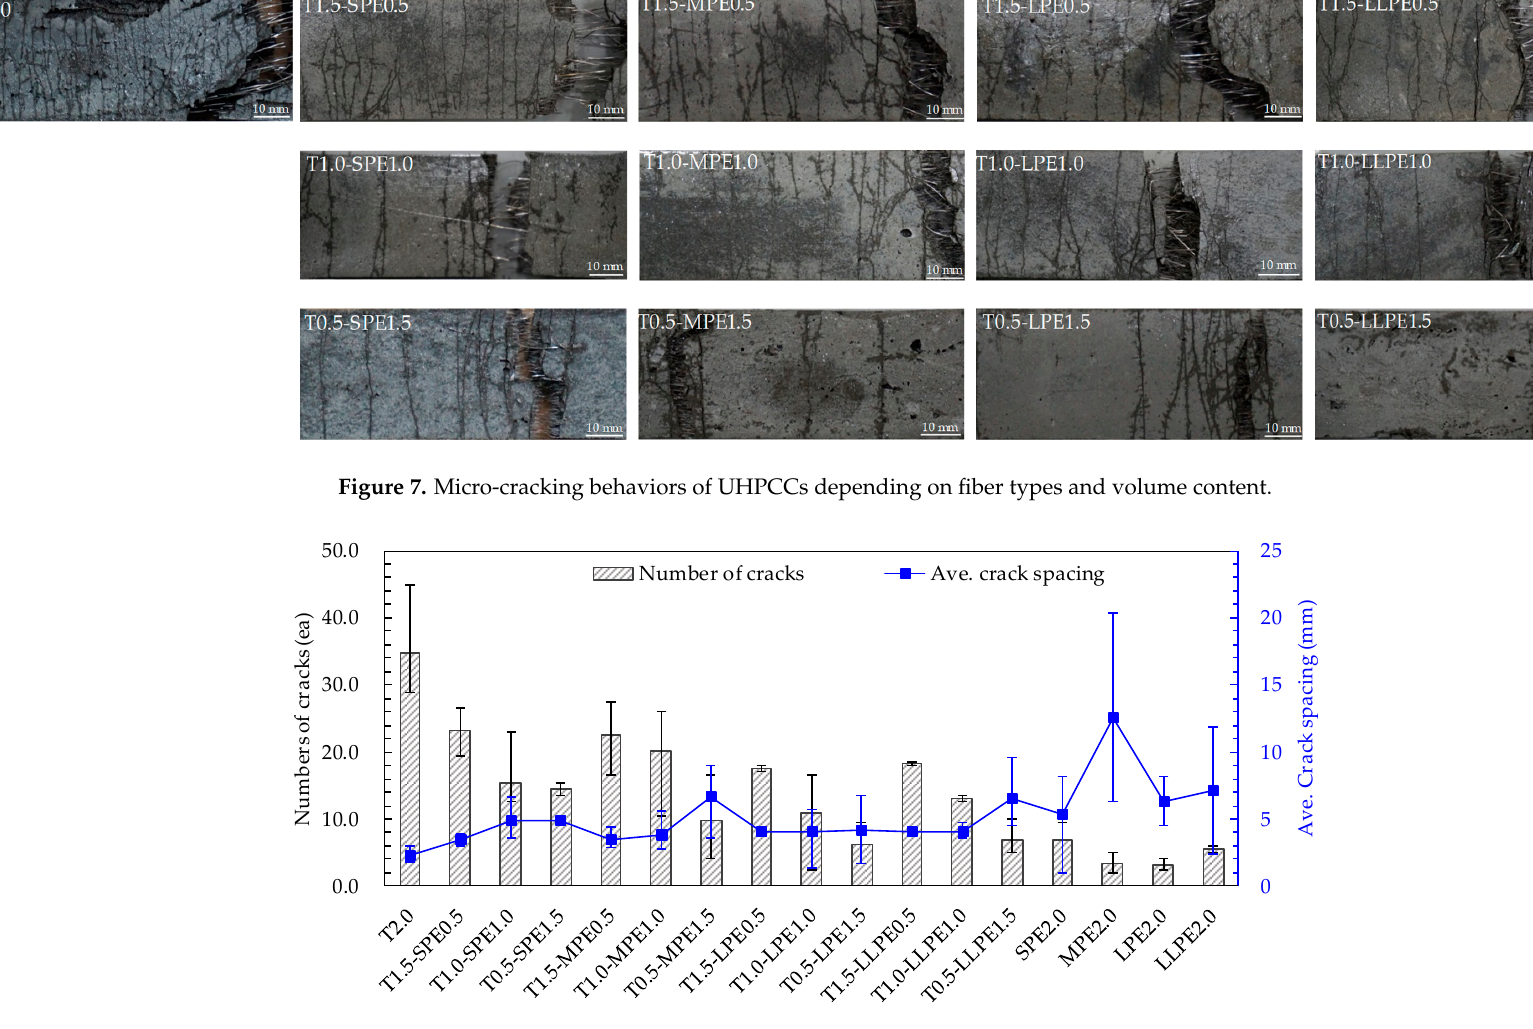
Figure 9. Matrix tearing off phenomenon of PE fibers in UHPCCs. 4. Conclusions The hybrid effects of T and PE fibers with four different aspect ratios on the mechanical properties of UHPCCs were investigated. Compressive and tensile tests were conducted for five specimens with single T or PE fibers and thirteen specimens with hybrid T and PE fibers at a constant overall fiber volume fraction of 2%. In addition, the fiber pullout mechanisms at crack surfaces were examined using a microscope to rationally analyze the tensile test results. From the above results and discussions, the following conclusions are drawn: (1) The compressive strength of UHPCCs increased proportionally to the volume fraction of T fibers. This effect was inversely proportional to the volume fraction of PE fibers, regardless of their aspect ratio. (2) T fibers were more effective in increasing the tensile strength of UHPCCs than PE fibers, while PE fibers were more effective in improving the strain capacity and energy absorption capacity of UHPCCs. (3) Using both T and SPE or MPE fibers led to a great synergetic effect that enhanced the tensile strength, strain capacity, and energy absorption capacity of UHPCCs relative to that with only T fibers. However, the specimens with T and LPE or LLPE fibers showed relatively minor improvements in the tensile performance. (4) For UHPCCs with hybridized T and PE fibers, the tensile performance was deteriorated by increasing the aspect ratio of PE fibers. This effect became more obvious with the higher volume content of PE fibers.